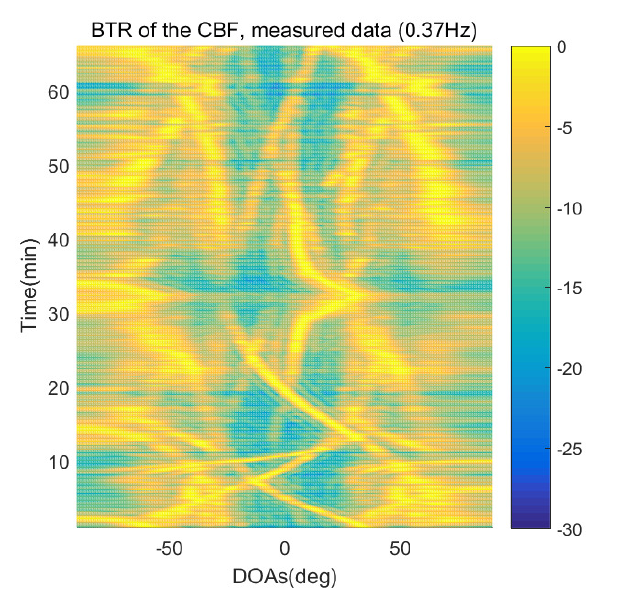
Figure 22. Bearing time records of the CBF: 66 min, signal frequency = 0.37 Hz.